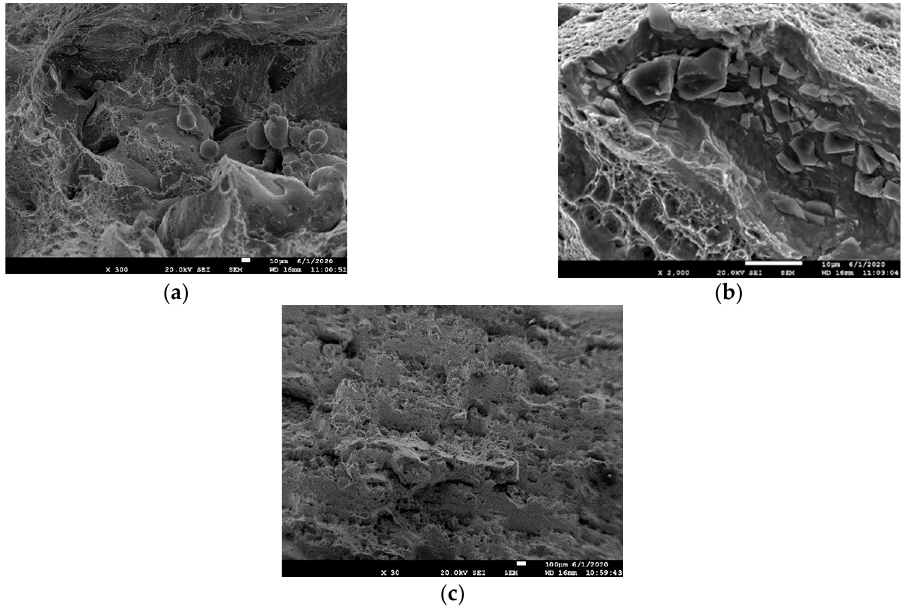
Figure 12. Stripes family 3 (samples 7–9) with ( a ) mixed-mode brittle and ductile fracture, ( b ) oxide scales, and ( c ) propagation along the fusion zones between each build layer, but with an increased degree of tortuosity and reduced length of propagation along each layer.